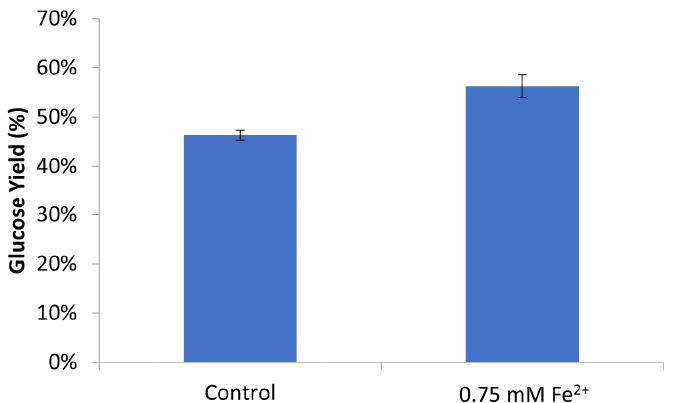
Figure 5. Glucose yield (based on glucan percent after pretreatment) during high ‐ solids enzymatic hydrolysis on unwashed solids.